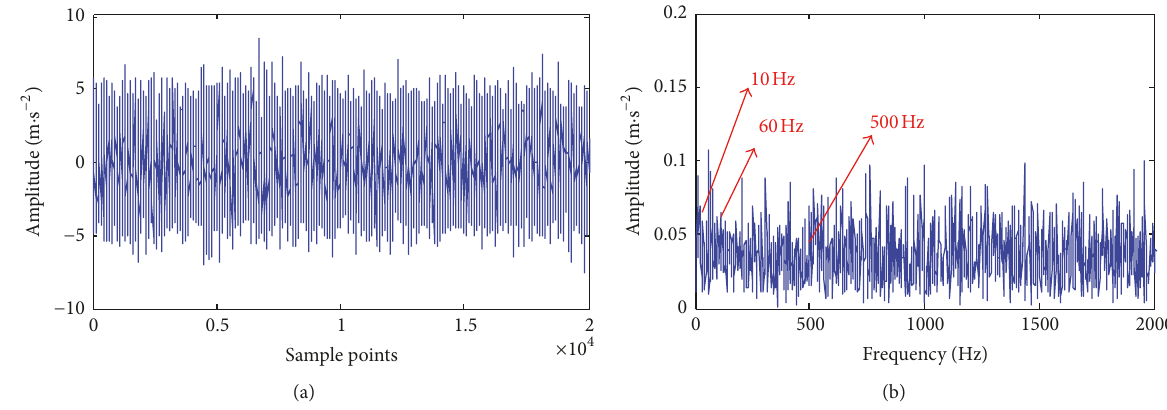
Figure 6: The time domain and spectrum of noisy